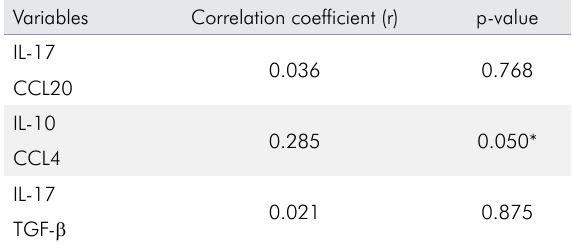
Table 3. Spearman correlation of the cytokines and chemokines IL-17/CCL20, IL-10/CCL4 and IL-17/ TGF- β .